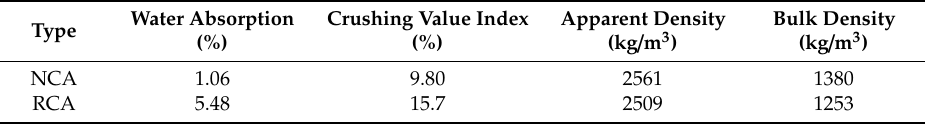
Table 3. Properties of coarse aggregate.